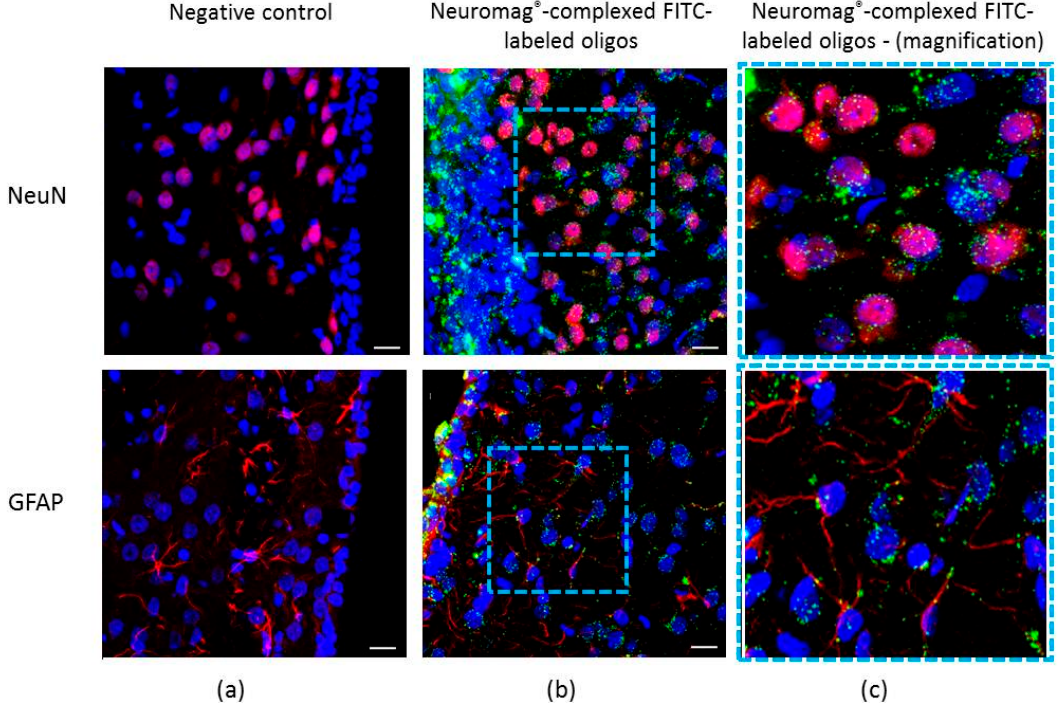
Figure 1. Magnetofection of striatal cells by fluorescein isothiocyanate (FITC)-labeled oligonucleotides complexed with Neuromag ® . Striatum region transfected with oligos structured in Neuromag ® for delivery into the neuron and glial cells. ( a ) Left rat striatum without intracerebroventricular (i.c.v.) injection (negative control); ( b ) NeuN-positive neuron cells transfected with green fluorescent FITC-labeled oligos; ( c ) Delineated region of ( b ) in high magnification revealing the green-labeled oligonucleotide inside neurons and glial cells (upper and bottom images, respectively). Immunostaining of NeuN and GFAP in red; FITC-labeled oligos in green; cell nucleus in blue, stained by the Hoescht 33342 reagent. Scale = 15 µm. n = 3 per group.